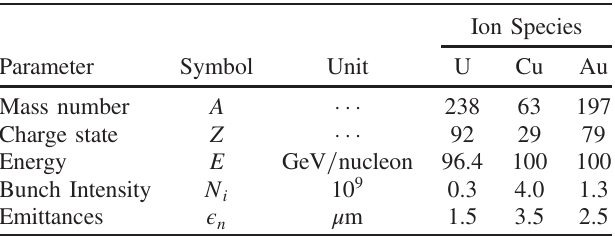
TABLE II. Ion and beam parameters in the 2012 ion run.